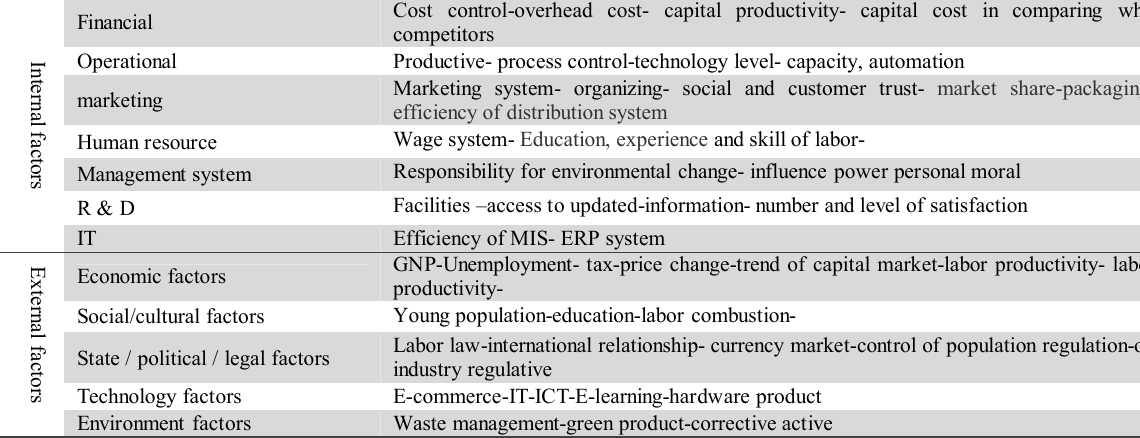
The internal and external factors of a hypothetical